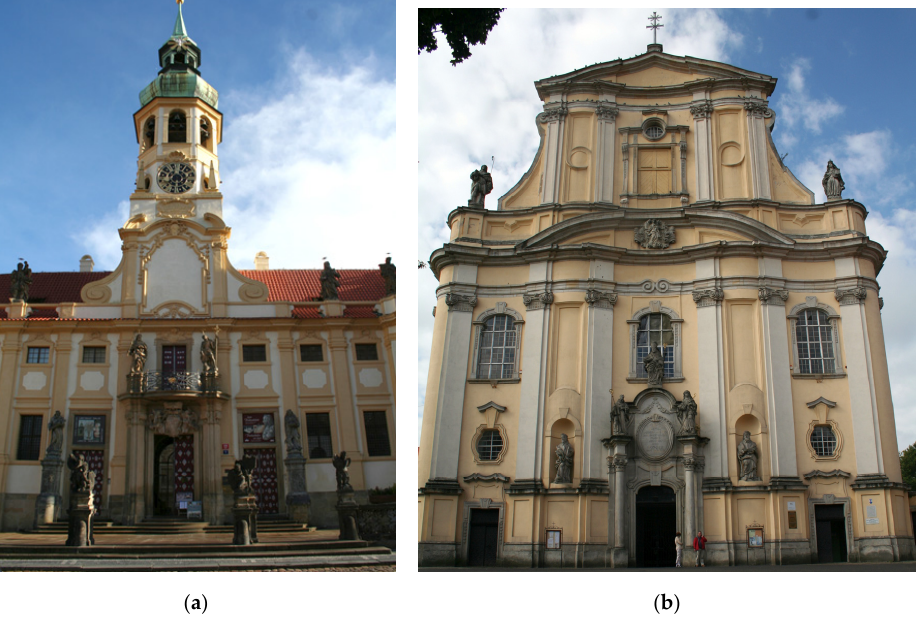
Figure 16. Continuity of multiplied elements of vertical division emphasized by color: ( a ) the monumental façade of the Loreto complex in Prague by Ch. and K.I. Dienzenhofer (1722–1726); ( b ) the façade of monastery church in Lubomierz (1728–1730, builder J.J. Scheerhofer). Photos by author.